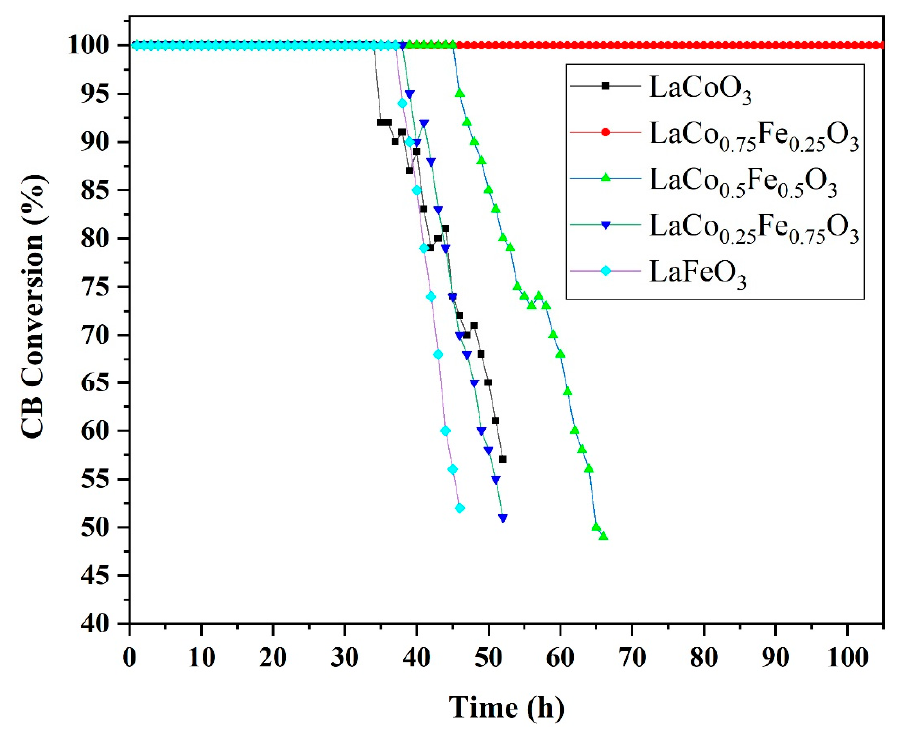
Figure 2. Stability test of chlorobenzene conversion as a function of reaction time.